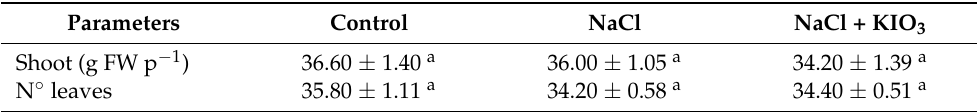
Different letters indicate statistically significant differences among treatments. p <